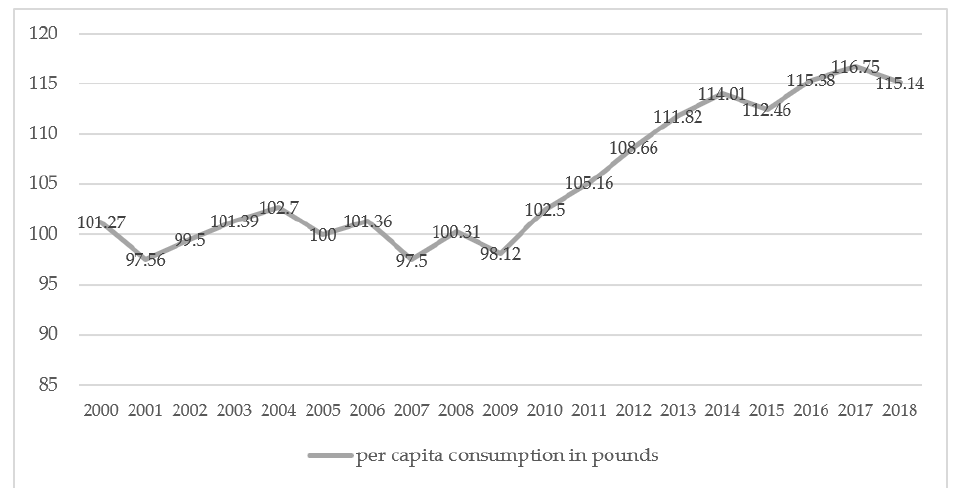
Figure A1. Per capita consumption of fresh fruit in the United States from 2000 to 2018 (in pounds). Source: Statista [56].